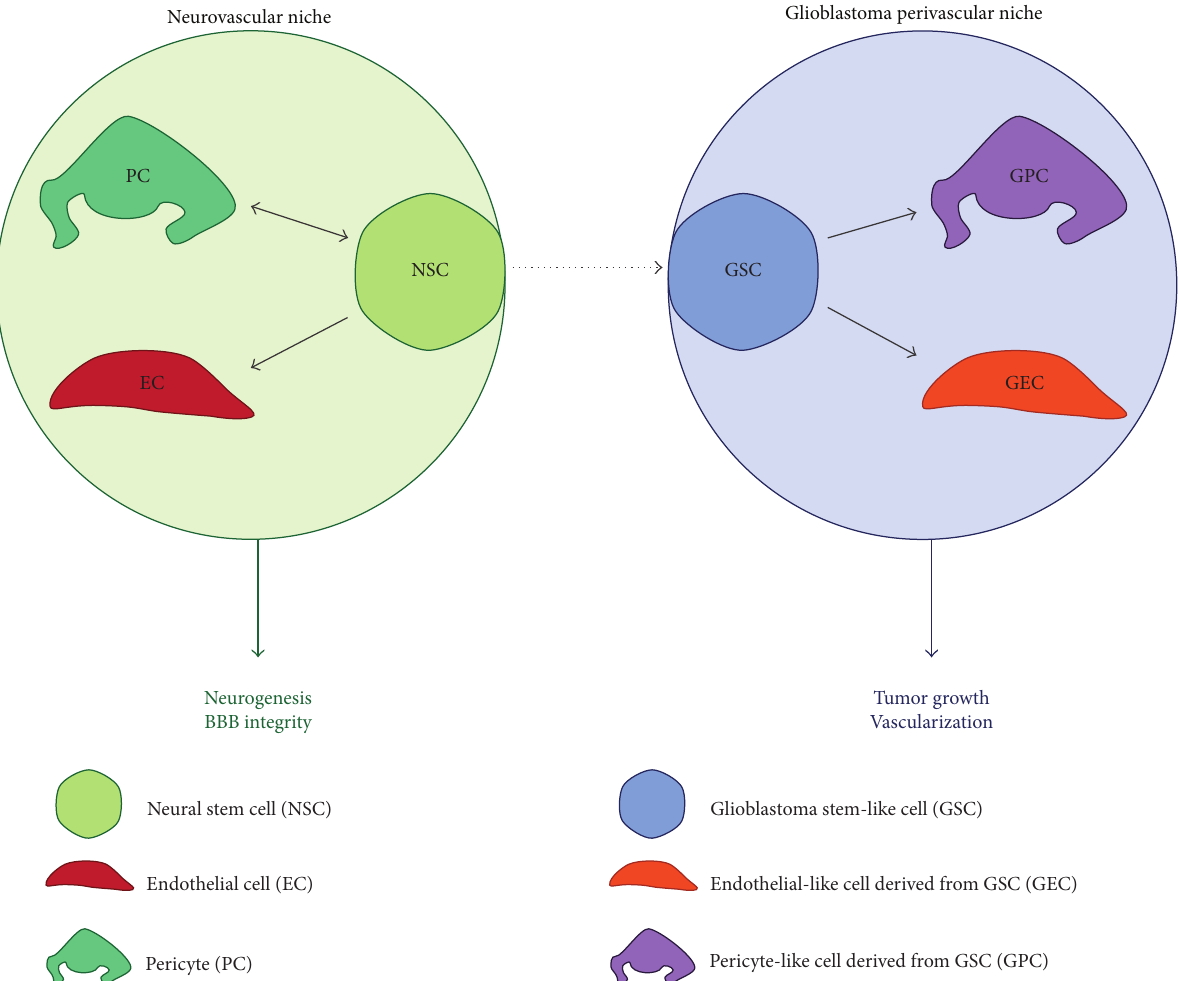
Figure 1: Schematic representation of the close interplay between neural stem cells (NSCs) and glioblastoma stem-like cells (GSCs) within their respective niches. NSCs are proposed to be at the origin of GSCs. Both NSCs and GSCs show transdifferentiation capacities towards the vascular lineage, that is, pericytes and endothelial cells. In both systems, this plasticity has consequences on the niche homeostasis: it influenceseitherneurogenesisandthebloodbrainbarrierintegrityinthephysiologicalneurovascularnicheortumoralgrowthandassociated vascularization in the glioblastoma